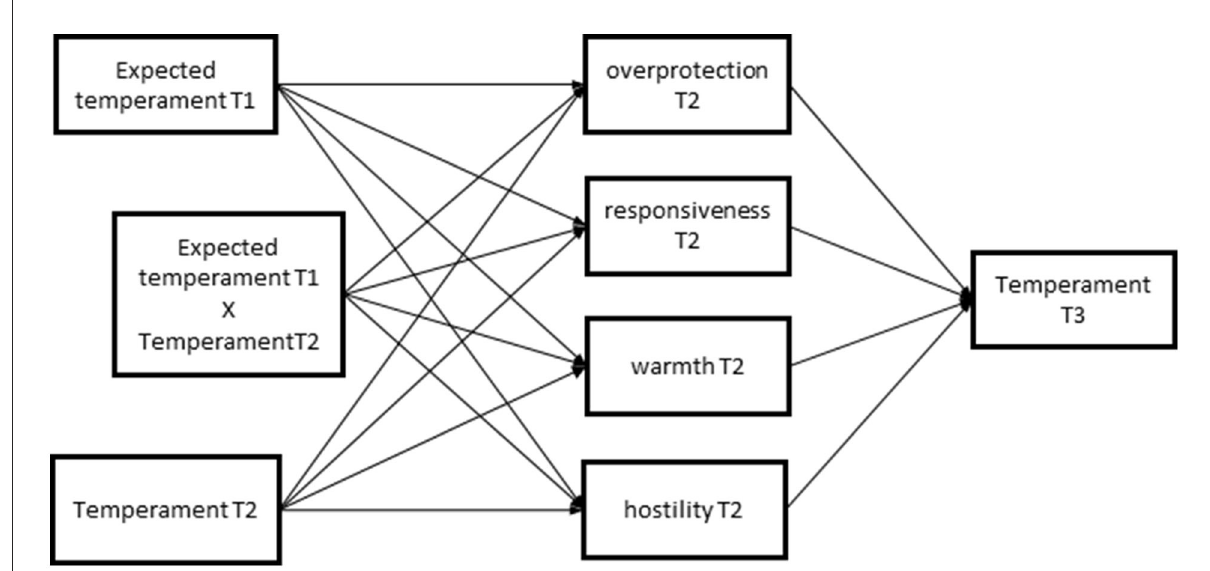
FIGURE1 Graphical representation of the estimated models including the interaction. Please note a direct effect from temperament T2 to temperament T3 was also included, as were squared terms for expected temperament and temperament at T2, and covariances between the parenting variables – but are not depicted in this figure for the sake of clarity. In our initial plan we had included covariances between expected temperament and temperament T2 and their interaction, but these resulted in estimation problems and had to be removed.